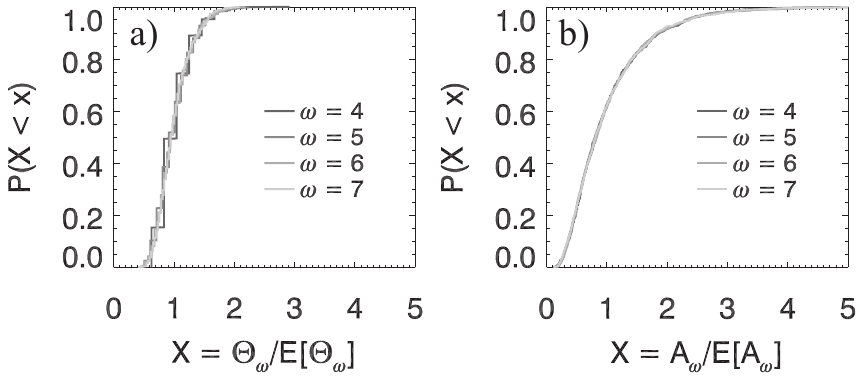
Fig. 10. The colapste of rescaled distributions indicates statistical self-similarity (SSS) in the (a) value of the maximum of the width function and (b) the distribution of basin areas.